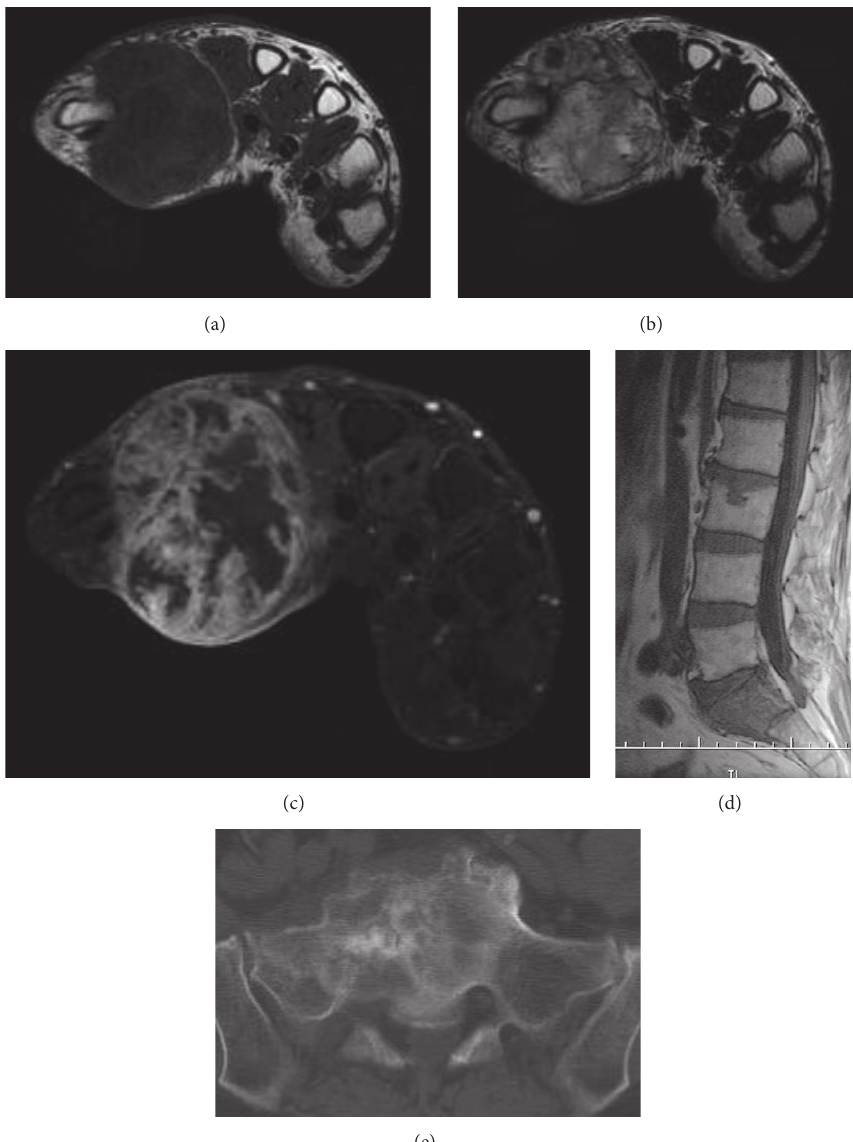
Figure 2: (a) T1 weighted, (b) T2 weighted, and (c) enhanced MRI images of the right hand suggested a malignant neoplasm. (d) MRI